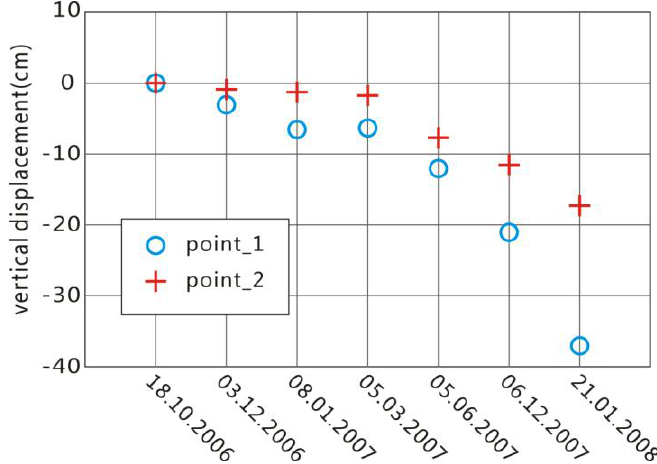
Figure 9. Displacement history for the two typical points (marked in Figure 6) within the coal fire zones 5 and 18. The circles signs represent the points in coal fire zone 5, which reveals an accelerated land subsidence phenomenon in this zone. The plus signs represent the points in coal fire zone 18, which indicates that this zone are newly subsiding areas during the period of the coal fire